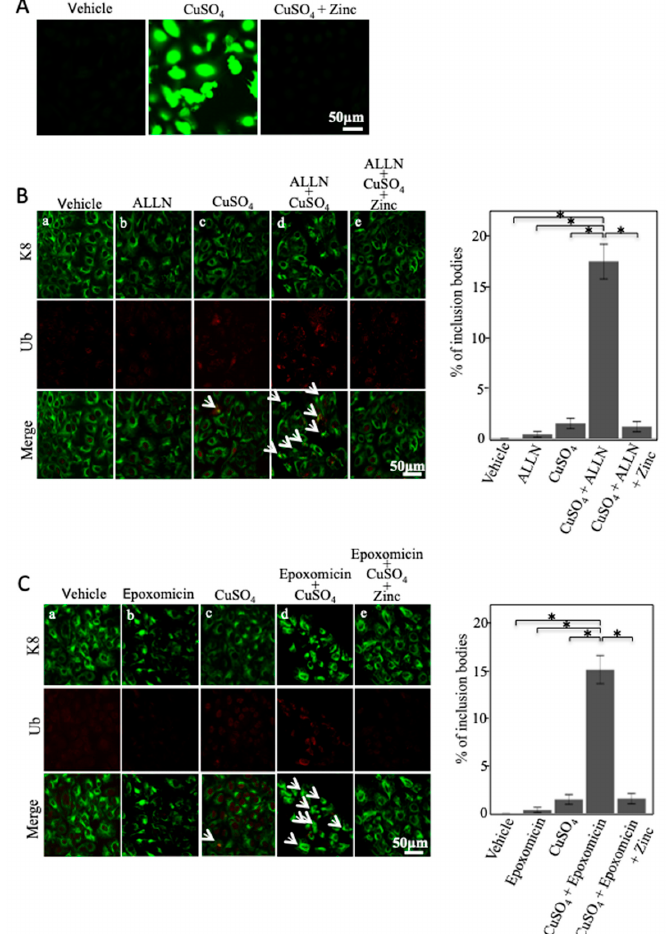
before copper sulfate treatment. Colocalizations of mRFP and GFP signals were measured by counting an overall total of 30 to 40 cells over the course of three independent experiments. Colocalization was shown as the percentage of merged signals in the total number of mRFP signals. Data are expressed as means ± SEM. ( G ) Huh7 cells were treated with zinc acetate at the concentration of 200 µ M for 2 h. Densitometry analysis of indicated proteins is shown on the right. ( H ) Huh7 cells were treated with copper at the concentration of 300 µ M and tunicamycin at the concentration of 0.5 µ M for 12 h, and zinc acetate (200 µ M) was added 2 h before copper sulfate treatment. Densitometry analysis of indicated Int. J. Mol. Sci. 2019 , 20 , x FOR PEER REVIEW proteins is shown on the right.